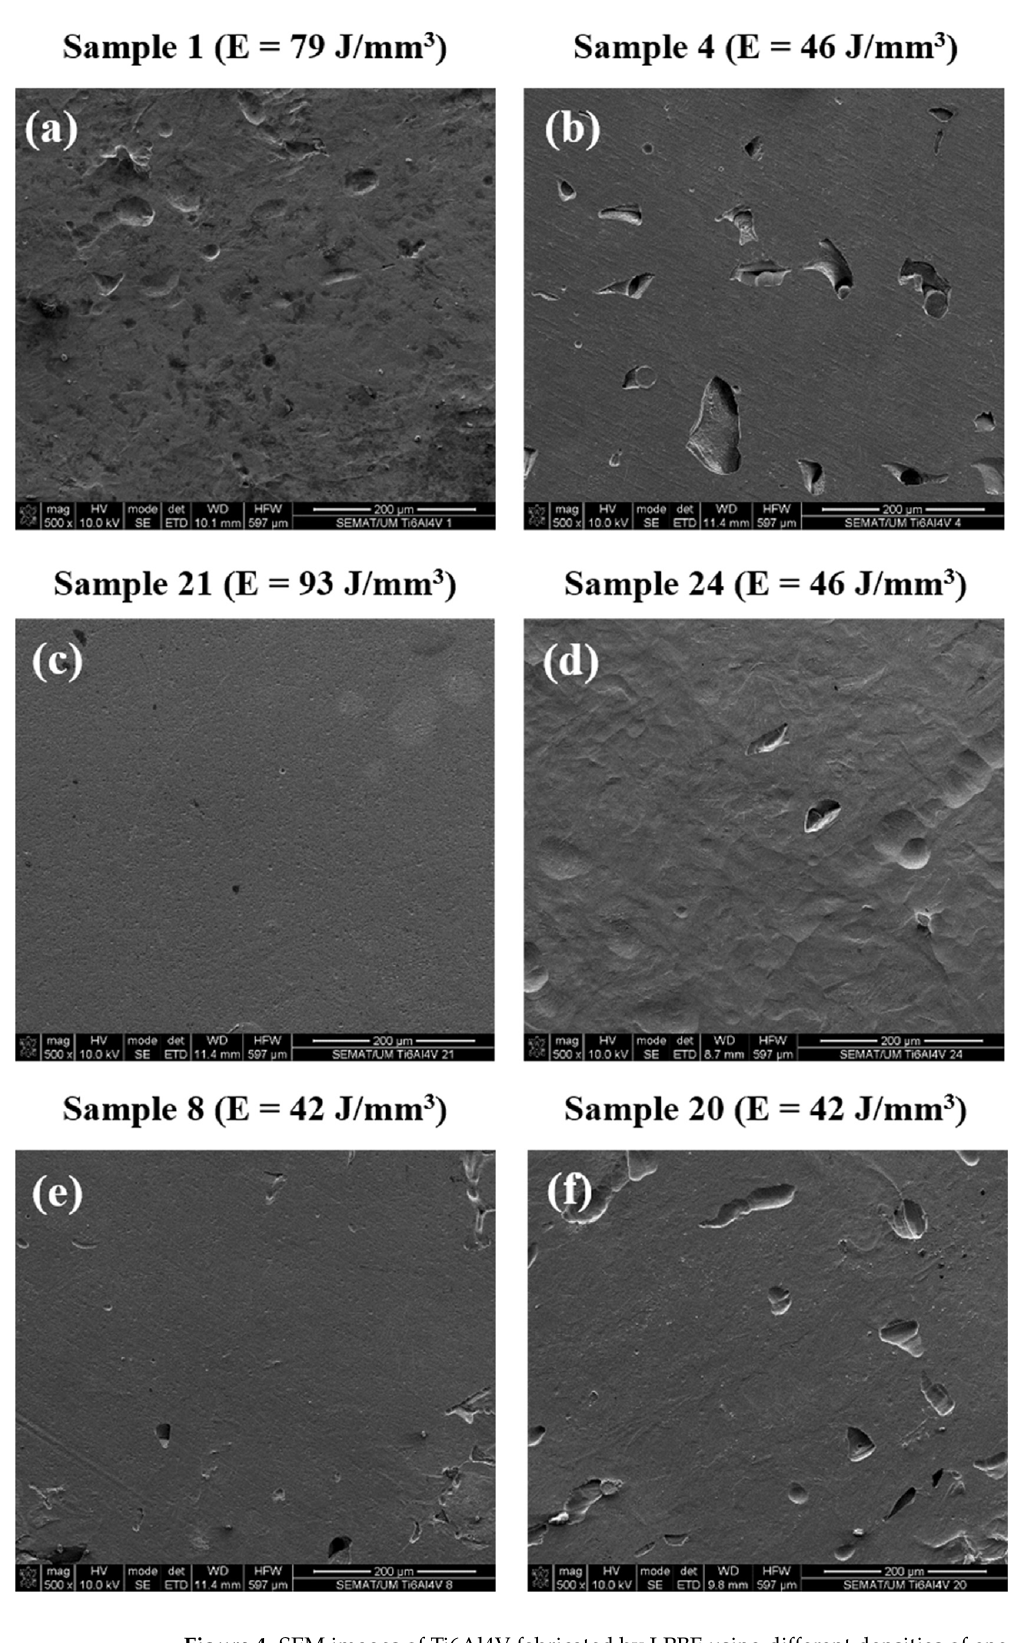
Figure 4. SEM images of Ti6Al4V fabricated by LPBF using different densities of energy (reproduced with permission from [3]. Copyright 2016 Elsevier).